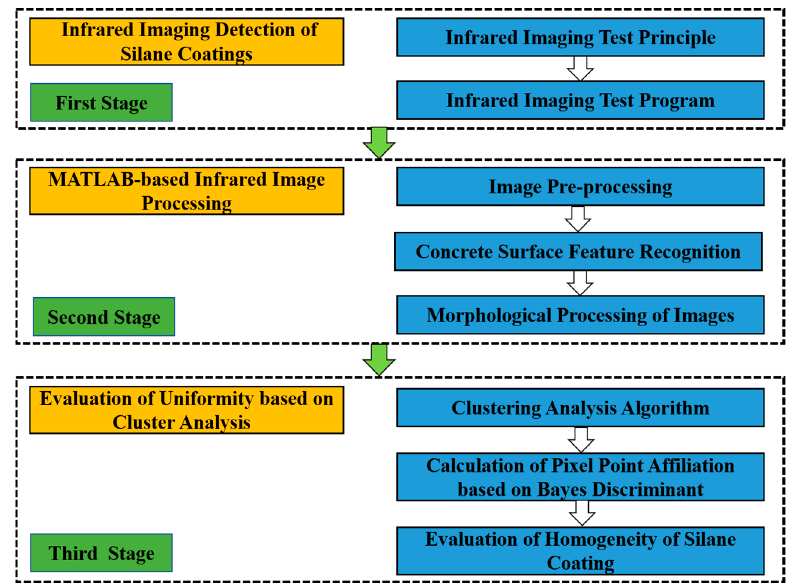
Figure 2. Flow chart of this study.